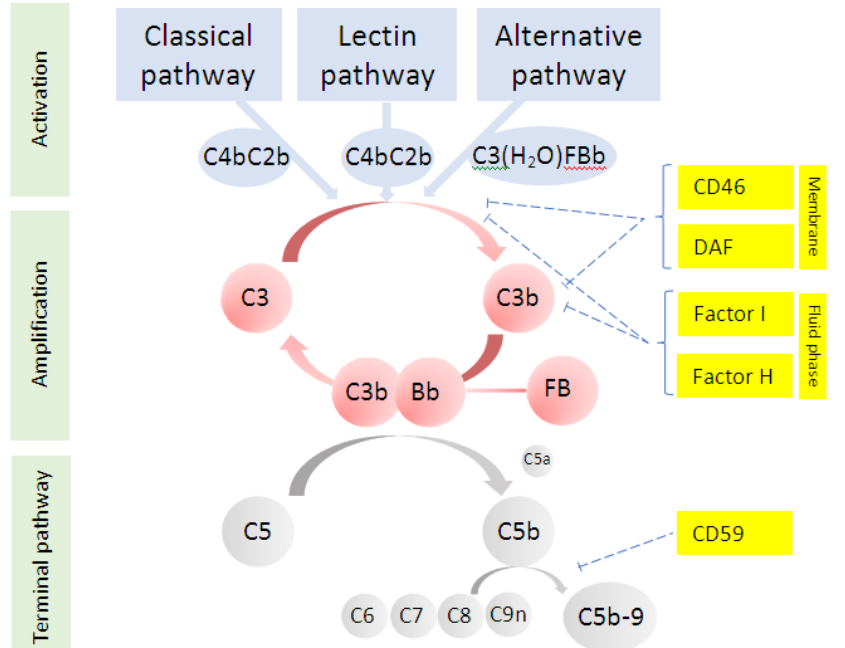
Figure 1. Activation of the complement cascade. DAF, decay accelerating